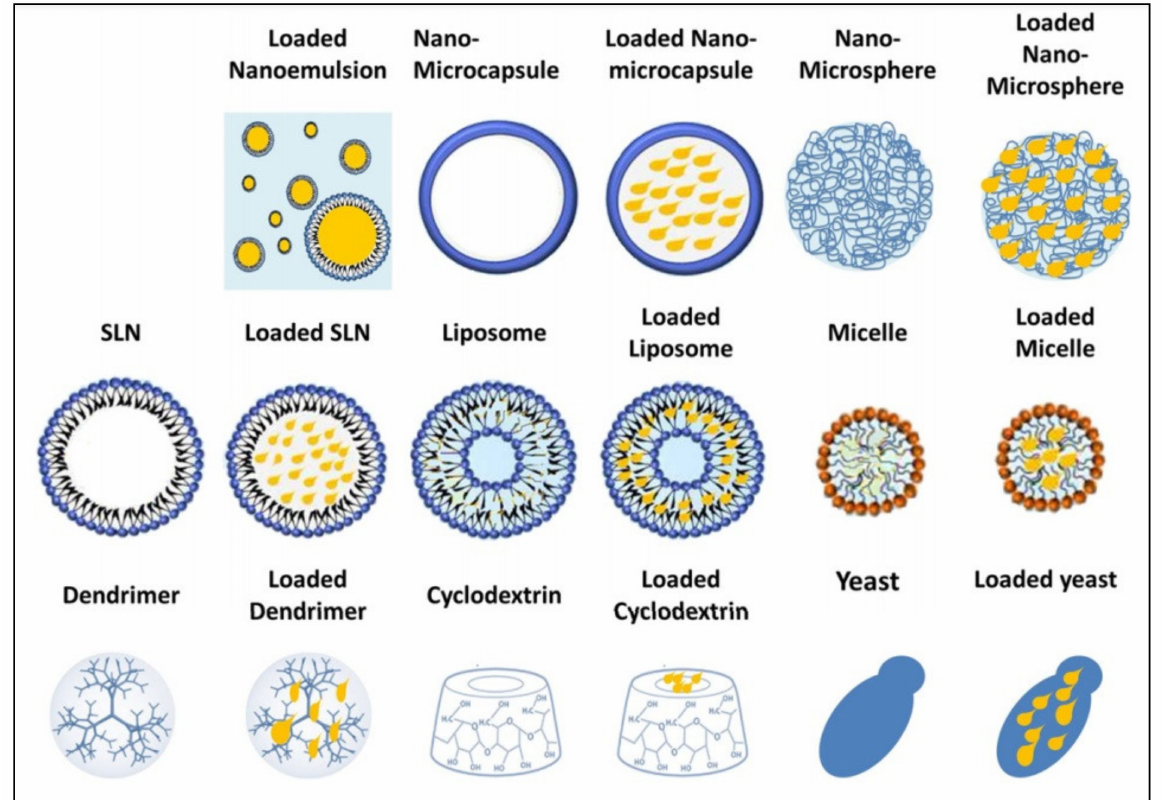
Figure 2. Various structures for bioactive oils encapsulation. Reprinted with permission from ref. [46]. Copyright 2016, Elsevier